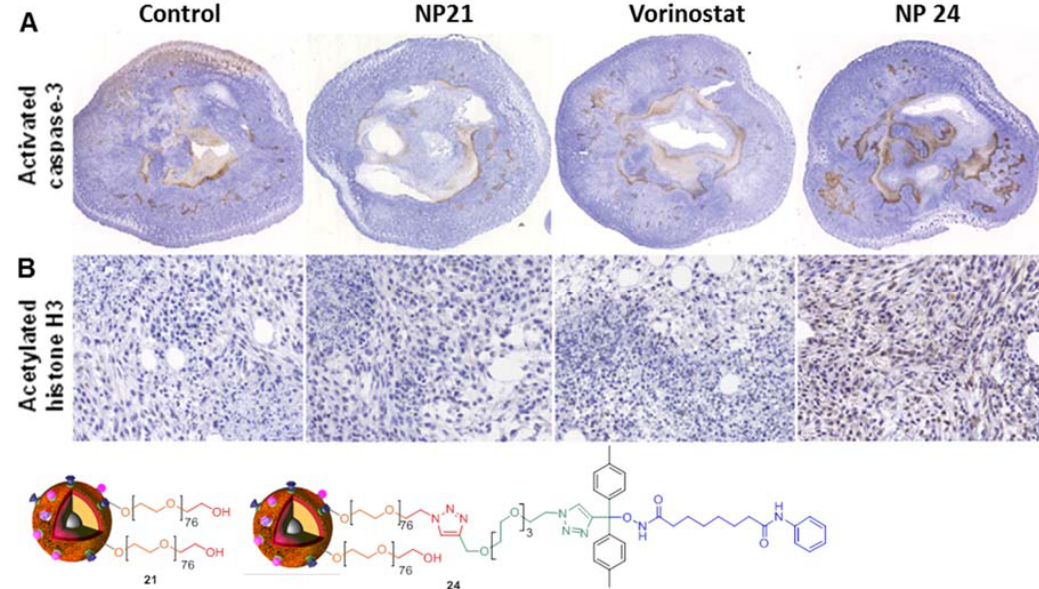
Figure 5. Histological analysis of tumors after treating mice with NPs 24 . Mice bearing subcutaneous AK7 tumors were injected IV with NPs 21 (160 mg/kg), with vorinostat alone (50 mg/kg), or NPs 24 (1.9 mg/kg vorinostat, 160 mg/kg polymer). Tumor tissues were analyzed using immuno ‐ histochemistry with anti ‐ activated capspase ‐ 3 antibody ( A ) or anti ‐ acetylated histone H3 antibody ( B ). Blue coloration: negative labeling, brown coloration: positive labeling.